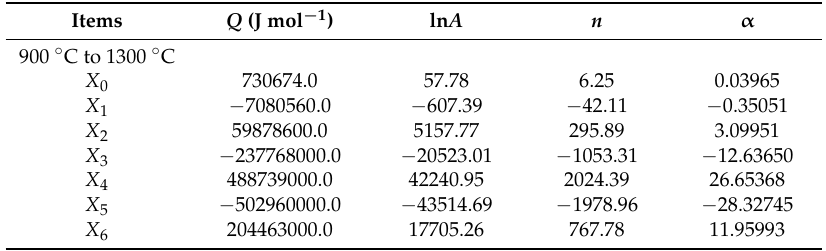
Table 2. Polynomial fitting coefficients of the material parameters ( X represents B , C , D , and E in Equation (2)).